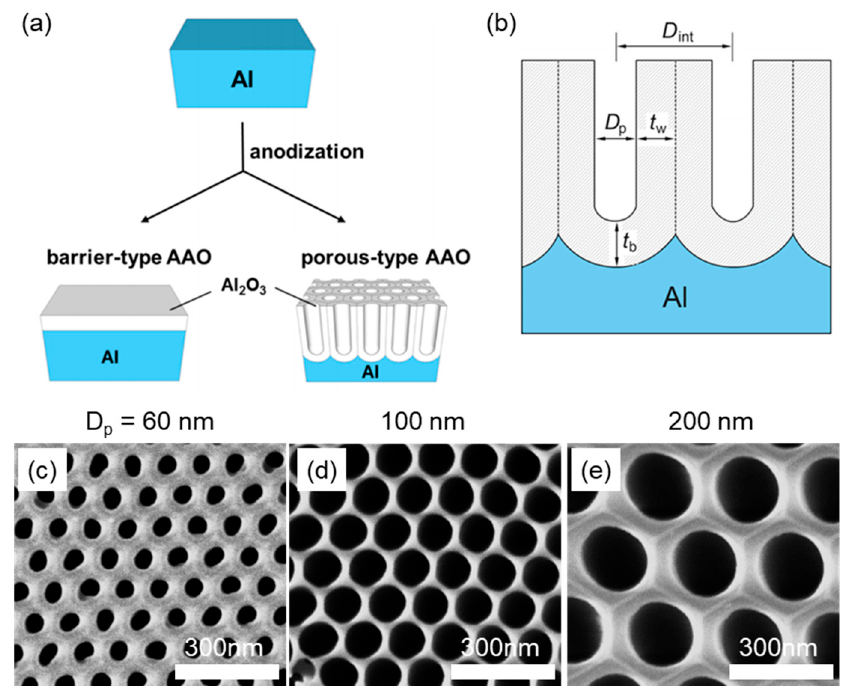
Figure 4. ( a ) Two types of AAO made from different anodizing electrolytes: barrier type and